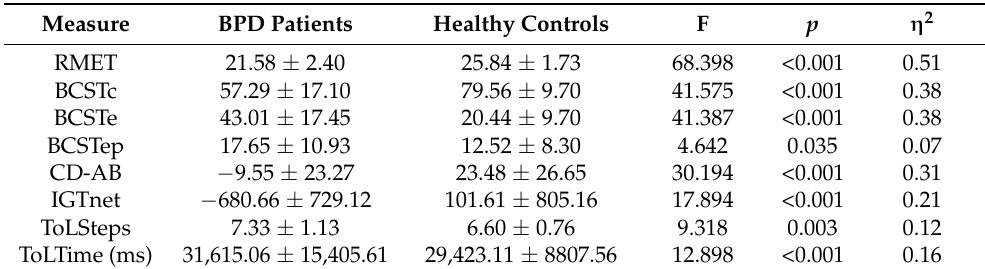
Table 2. Comparison (with ANOVA) of the baseline values of measures of cognitive domains between the BPD and healthy control groups a